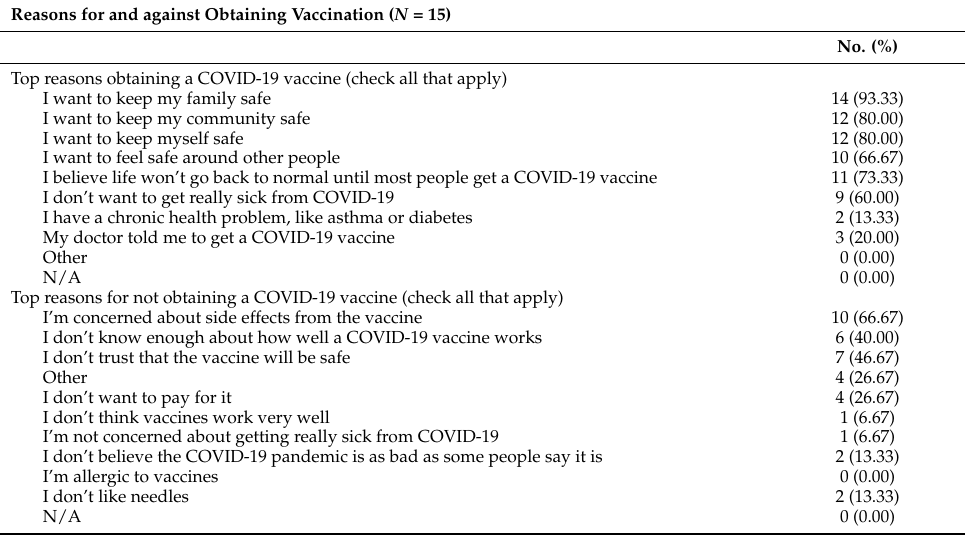
Table 3. Latino Focus Group Participant